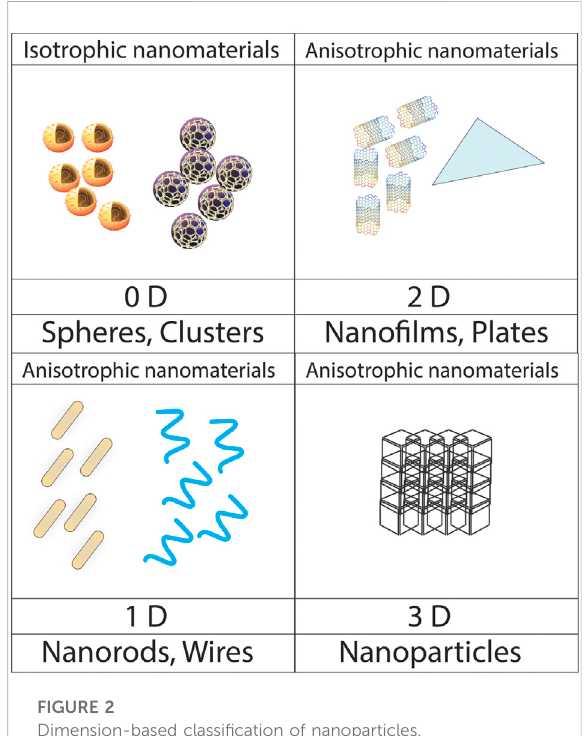
FIGURE 2 Dimension-based classi fi cation of